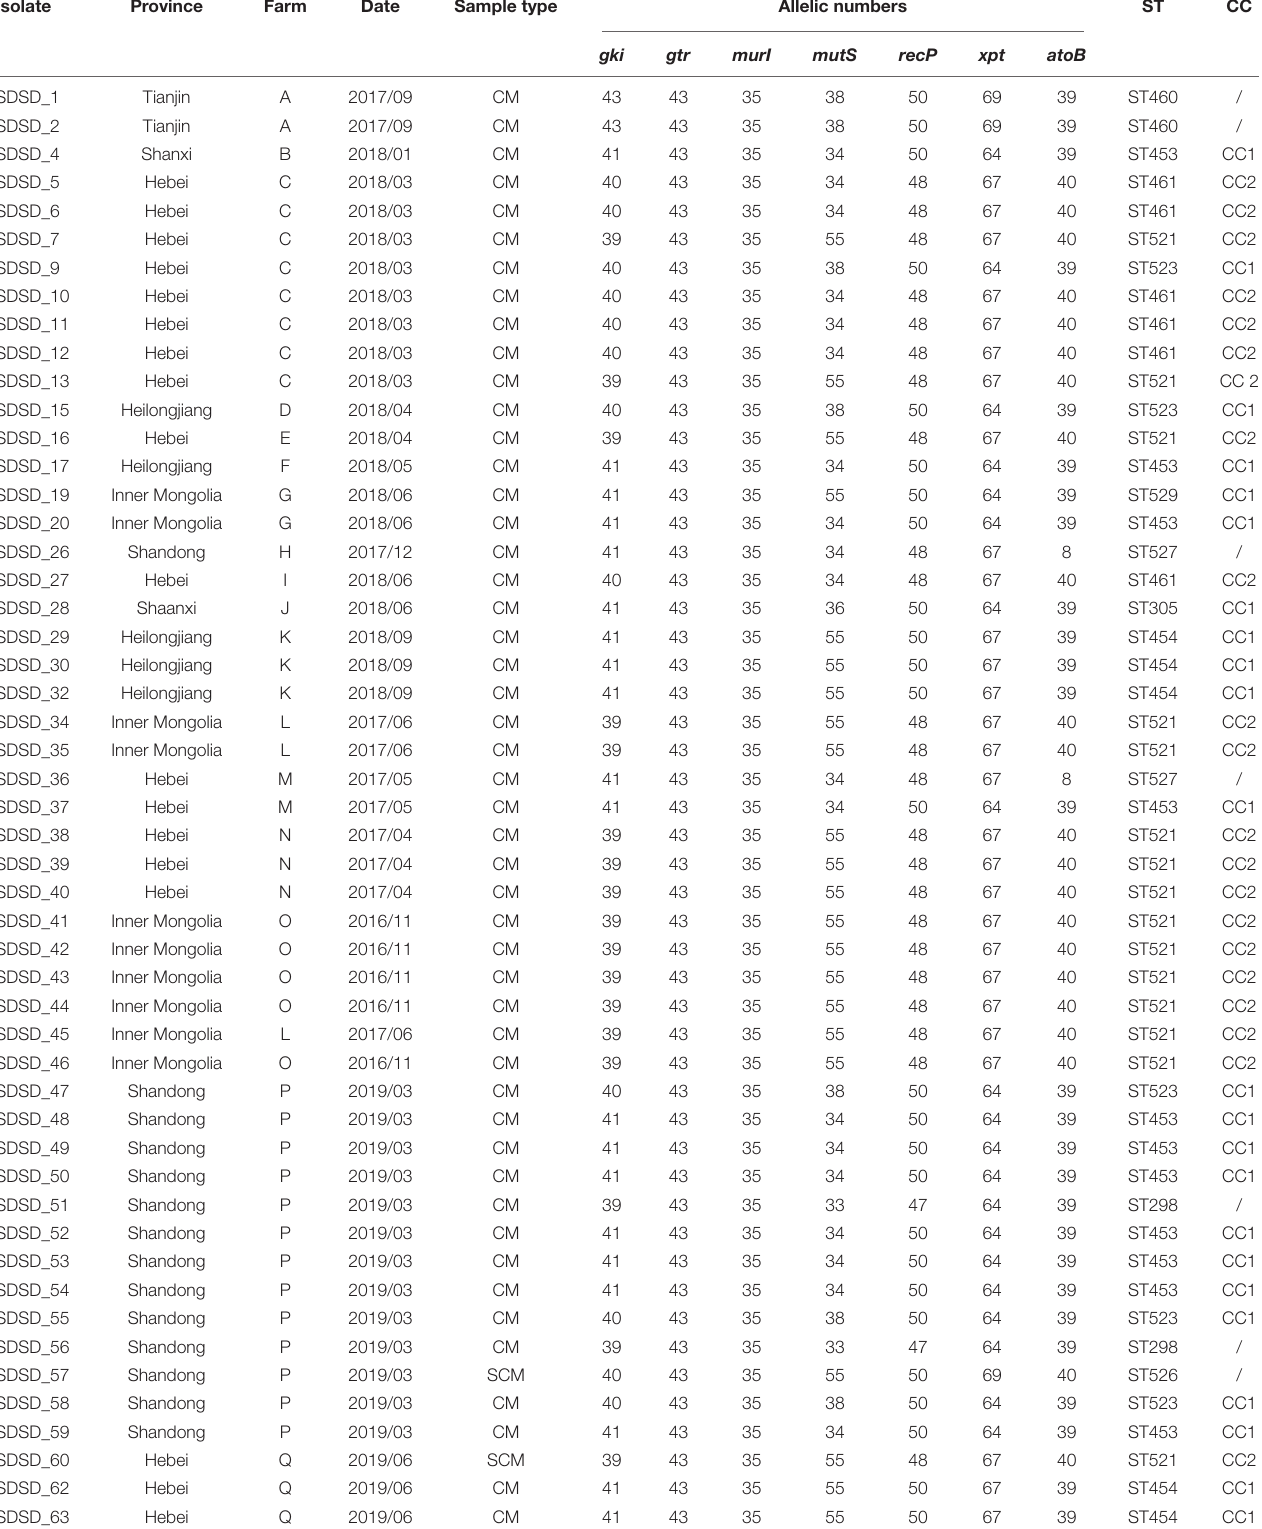
TABLE 2 | Streptococcus dysgalactiae subsp. dysgalactiae isolate ( n = 51) recovered from 509 bovine clinical mastitis (CM) and 165 subclinical mastitis (SCM) milk samples collected from farms in China and their genotypes. Isolate Province